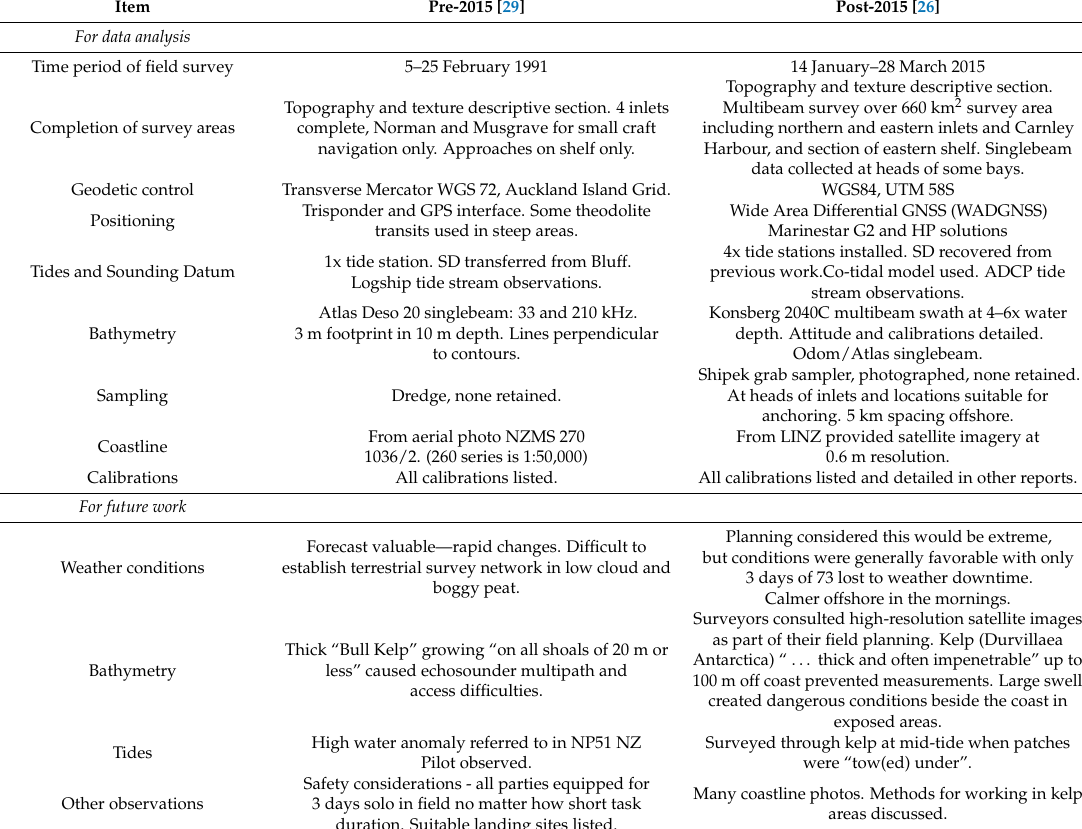
Table 2. Auckland Islands survey report